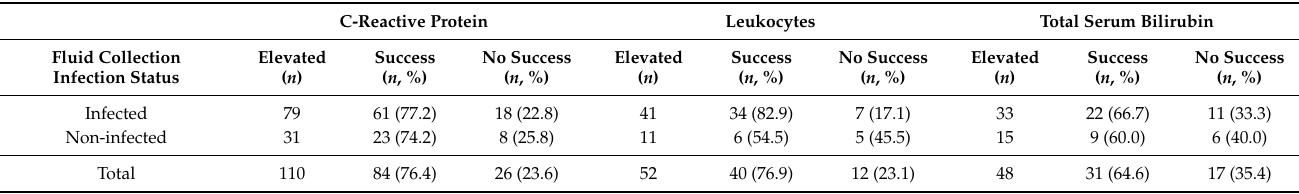
Table 6. Distribution of the success rate in terms of decreasing laboratory parameters between infected and non-infected fluid